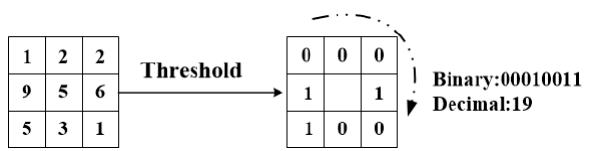
Figure 6. Basic LBP coding method.